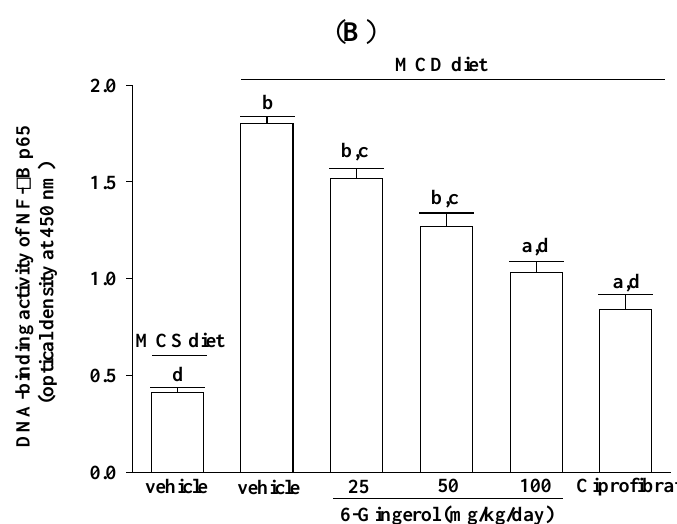
Figure 6. Different treatment effects on IκBα and NF-κB expression and NF-κB binding activity in liver tissue. ( A ) Protein expression of IκBα and NF-κB p65, and ( B ) DNA binding activity of NF-κB p65 in the livers of MCS diet- and MCD diet-fed mice after four weeks of treatment. MCD diet-fed mice were administered either 6-gingerol at 25 mg/kg/day (MCD + 6-gingerol 25), 50 mg/kg/day (MCD + 6-gingerol 50), or 100 mg/kg/day (MCD + 6-gingerol 100) or 10 mg/kg/day of ciprofibrate (MCD + ciprofibrate) by oral gavage once daily for four weeks. Additional groups of MCD diet-fed mice (MCD + vehicle) and MSD-fed mice (MSD + vehicle) were administered the same volume of vehicle (distilled mice/group after four weeks of treatment. a p < 0.05 and b p < 0.01 compared to the